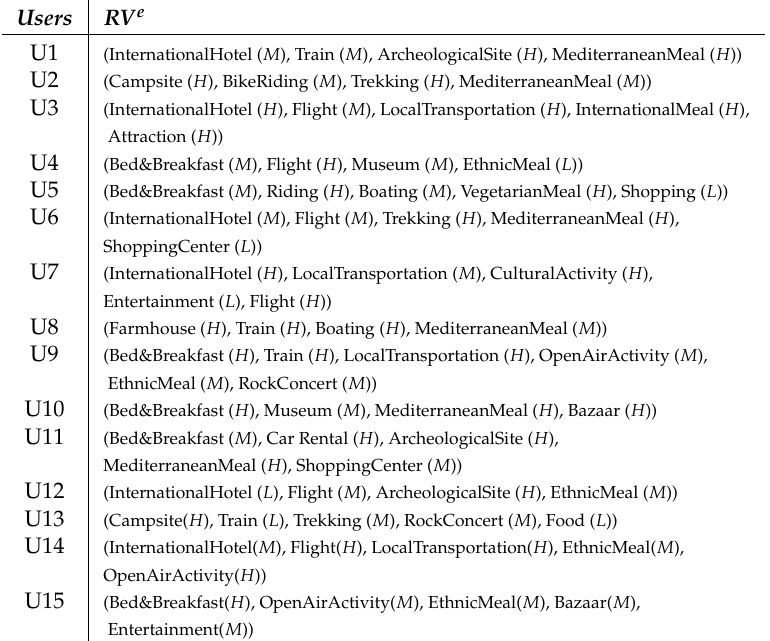
Table 3. Request vectors.